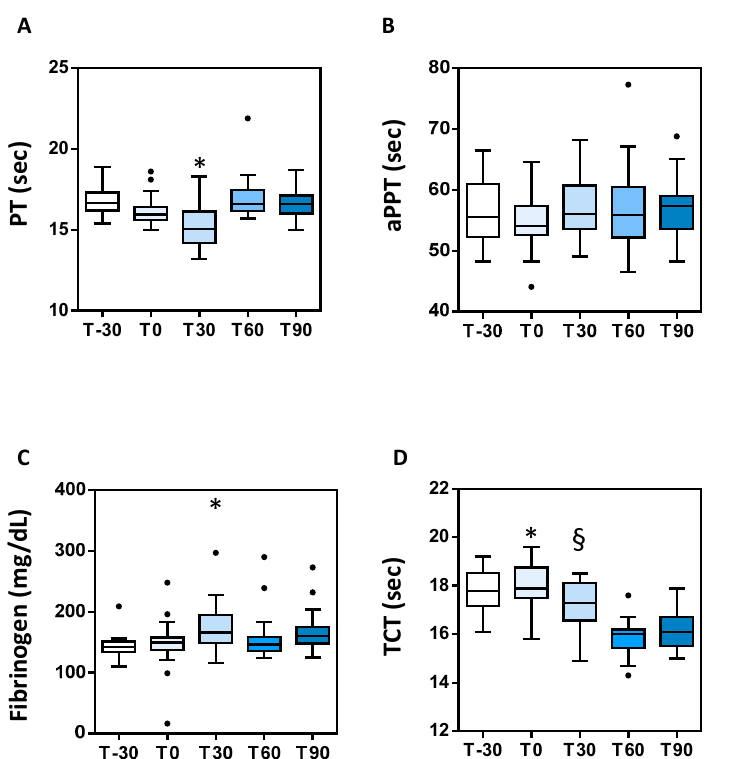
Figure 2. Boxplot with coagulation parameters in the time series. ( A ) Prothrombin time (PT), * = p < 0.05 vs. all; ( B ) activated partial thromboplastin time (APTT); ( C ) fibrinogen * = p < 0.05 vs. T-30 and T60; ( D ) thrombin clotting time (TCT) * = p < 0.05 vs. T30, T60 and T90, § = p < 0.05 vs. T60 and T90. Circles in the plot area represent outliers.